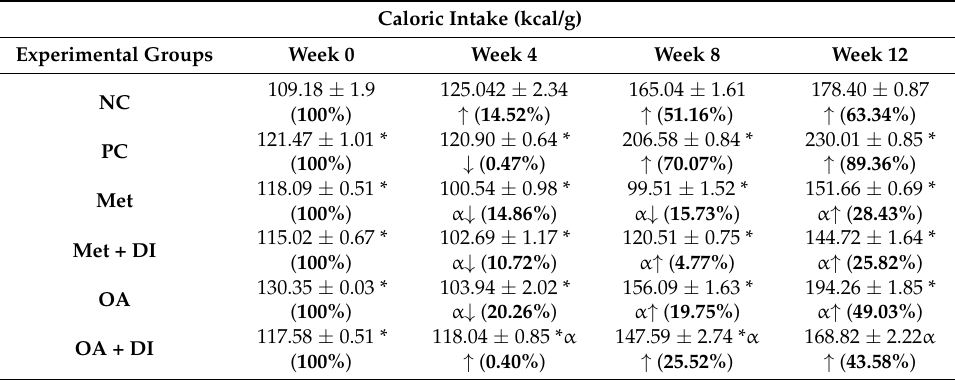
Table 1. Effects of OA on food intake of rats that continued with HFHC diet during treatment and those that changed the diet. Values are presented as standard error of mean ± SEM and in percentage increase ( ↑ = increase and ↓ =